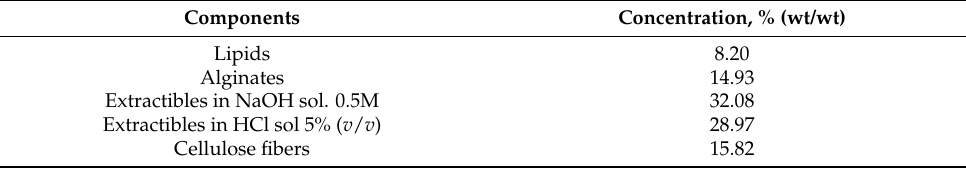
Table 1. Composition of Cystoseira barbata powder.